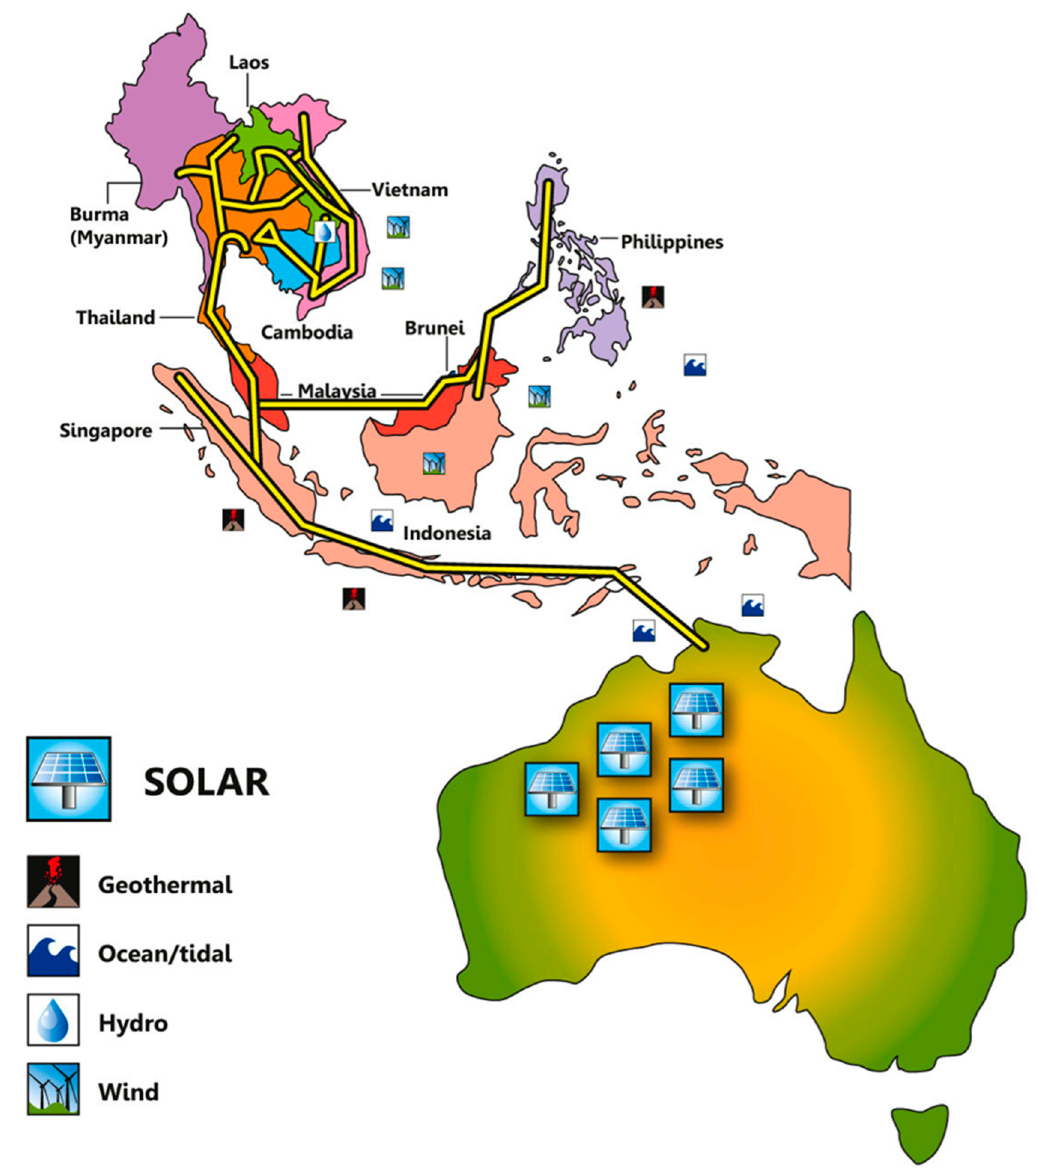
Figure 1. An example of grid connection between Australia and ASEAN. Figure taken from [33].